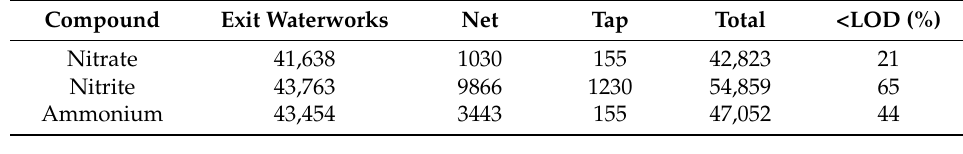
Table 1. Nitrate, nitrite, and ammonium measurements taken in public water supply systems between 2007 and 2016 by sampling location and percentage of samples below detection limit (<LOD).